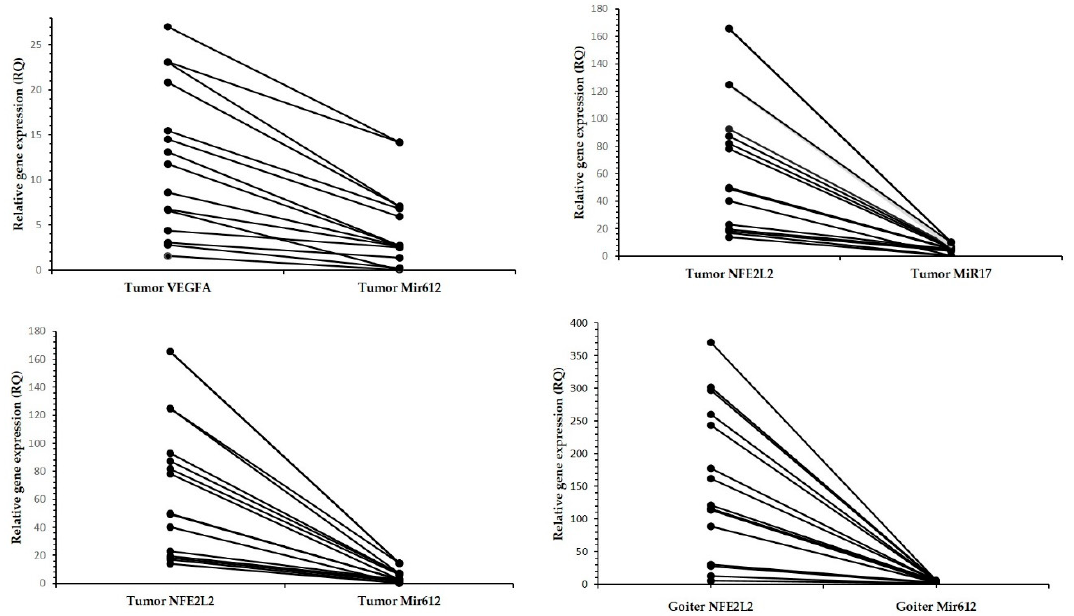
Figure 2. Relationship between relative expression levels of miRs and genes, showing high expression levels of genes and low expression levels of miRs. Each point represents an individual sample, for which the two gene expression levels are correspondingly connected. RQ, relative quantification.